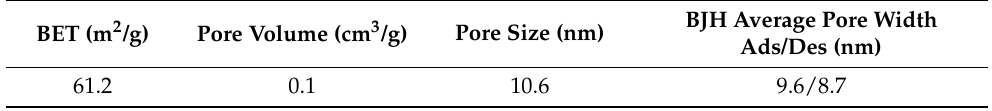
Table 1. The specific surface area, pore size, pore volume and BJH average pore width of NiCdTiO 2